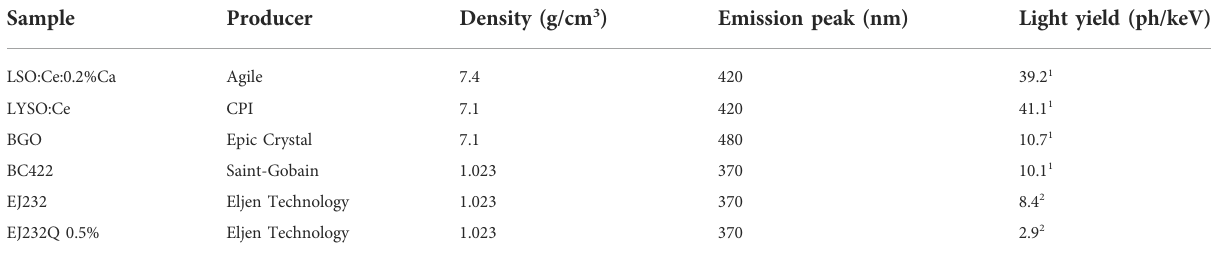
TABLE 1 Overview of the scintillators used in this work, all with size 3 × 3 × 3 mm 3 . Sample